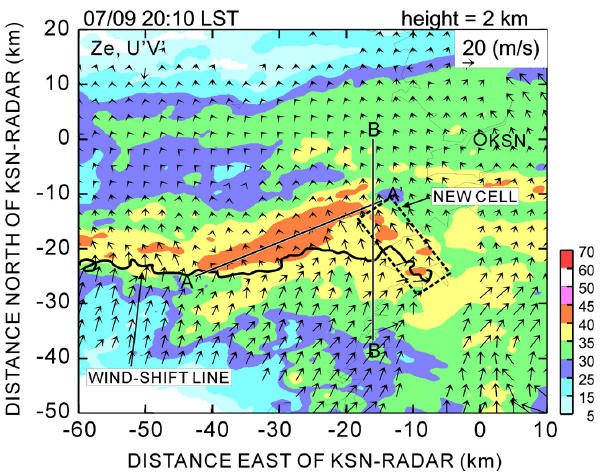
Fig. 12. Horizontal distributions of reflectivity and system relative wind vector at 2km a.s.l. at 20:10LST, 9 July 2007. The bold lines indicate the vertical cross-sections in Fig. 13.